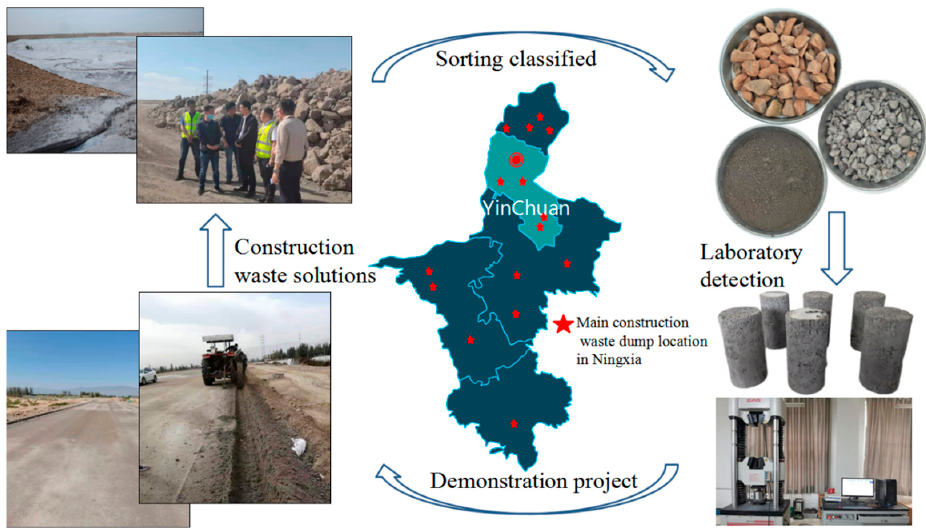
Figure 10. CFRBCA regeneration